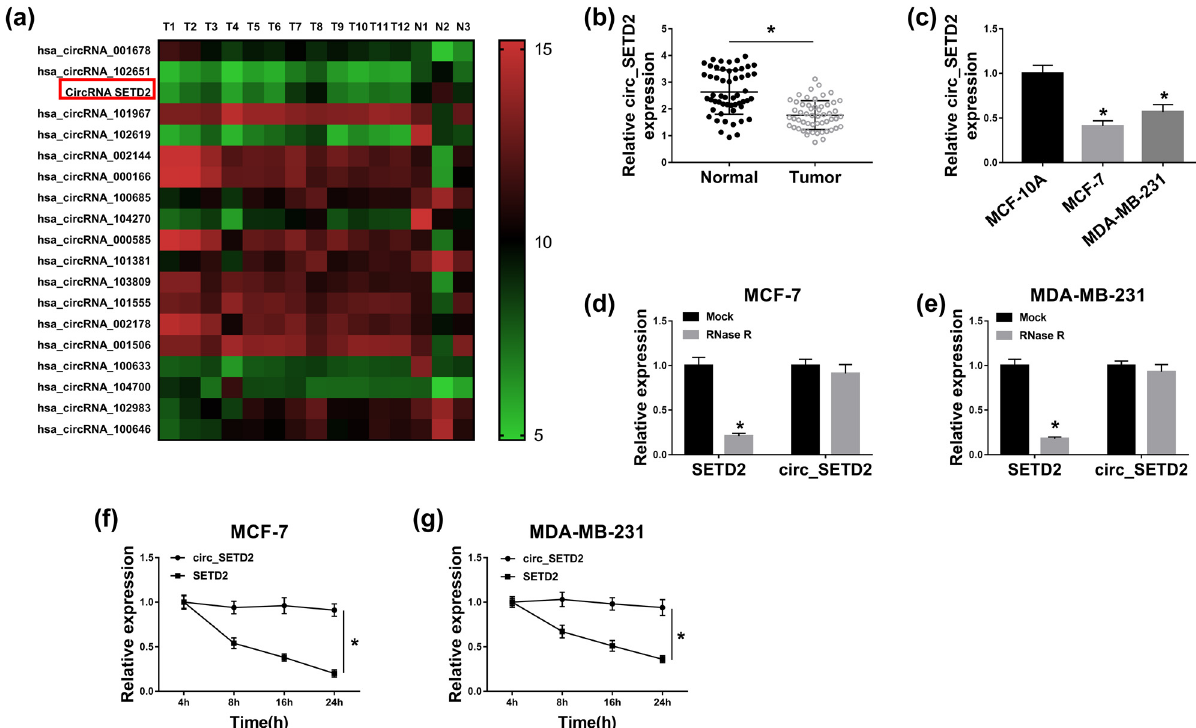
Figure 1: Identi fi cation and expression of circ_SETD2 in BC tissues and cells. ( a ) The expression of circ_SETD2 in BC tissues in comparison to normal tissues was analyzed by using the GEO dataset GSE101124. ( b and c ) Relative circ_SETD2 expression in BC tissues and adjacent normal tissues, as well as BC cells ( MCF - 7 and MDA - MB - 231 ) and MCF - 10A cells was examined by qRT - PCR. ( d and e ) The levels of circ_SETD2 and SETD2 in total RNA of MCF - 7 and MDA - MB - 231 cells with or without RNase R treatment were analyzed by qRT - PCR. ( f and g ) The levels of circ_SETD2 and SETD2 in MCF - 7 and MDA - MB - 231 cells treated with actinomycin D for di ff erent times were assessed with qRT - PCR. The data are presented as mean ± standard deviation; paired Student ’ s t test was utilized to compare the di ff erences between BC tissues and adjacent normal tissues; one - way ANOVA followed by Tukey ’ s post hoc test was utilized to compare the di ff erences among groups; the experiments were repeated three times independently. * P <